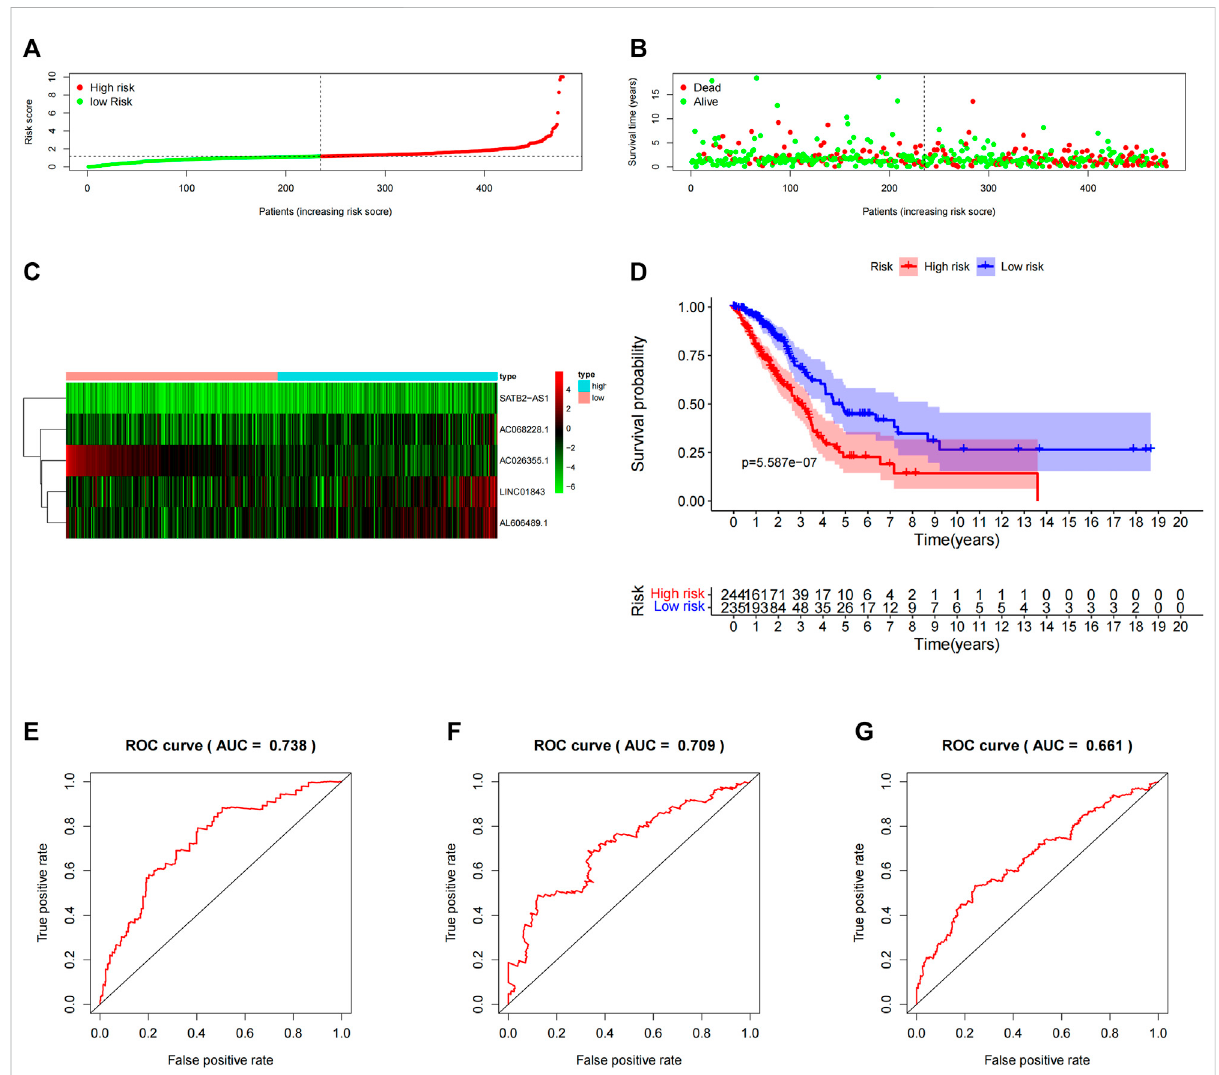
FIGURE 4 Assessmentofthe5-lncRNAsignatureinthe “ entiredataset ” . (A) Theriskscoredistributioninthe “ entiredataset ” . (B) TheOSstatusinthe “ entire dataset ” . (C) TheOS-relatedlncRNAsexpressionheatmapsofthe5-lncRNAsignatureinthe “ entiredataset ” . (D) TheKaplan – Meiercurvescomparing OS between the high-risk groups ( n = 244) and the low-risk groups ( n = 235) in the “ entire dataset ” . Blue- and red-shaded sections indicate the con fi dence intervals for survival. The number of patients at risk is listed below the curve. (E) Time-dependent ROC curve based on 5-lncRNA signature predicting 1 year-OS in the “ entire dataset ” . (F) Time-dependent ROC curve based on 5-lncRNA signature predicting 3 years-OS in the “ entire dataset ” . (G) Time-dependent ROC curve based on 5-lncRNA signature predicting the 5 years-OS in the “ entire dataset ”